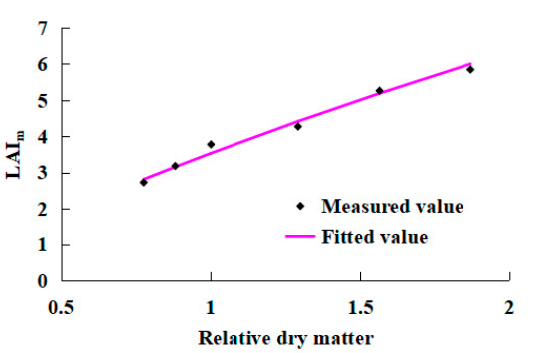
Figure 8. Relationship between maximum leaf area index (LAI m ) and relative dry biomass for treatments X1–X6 in 2009.